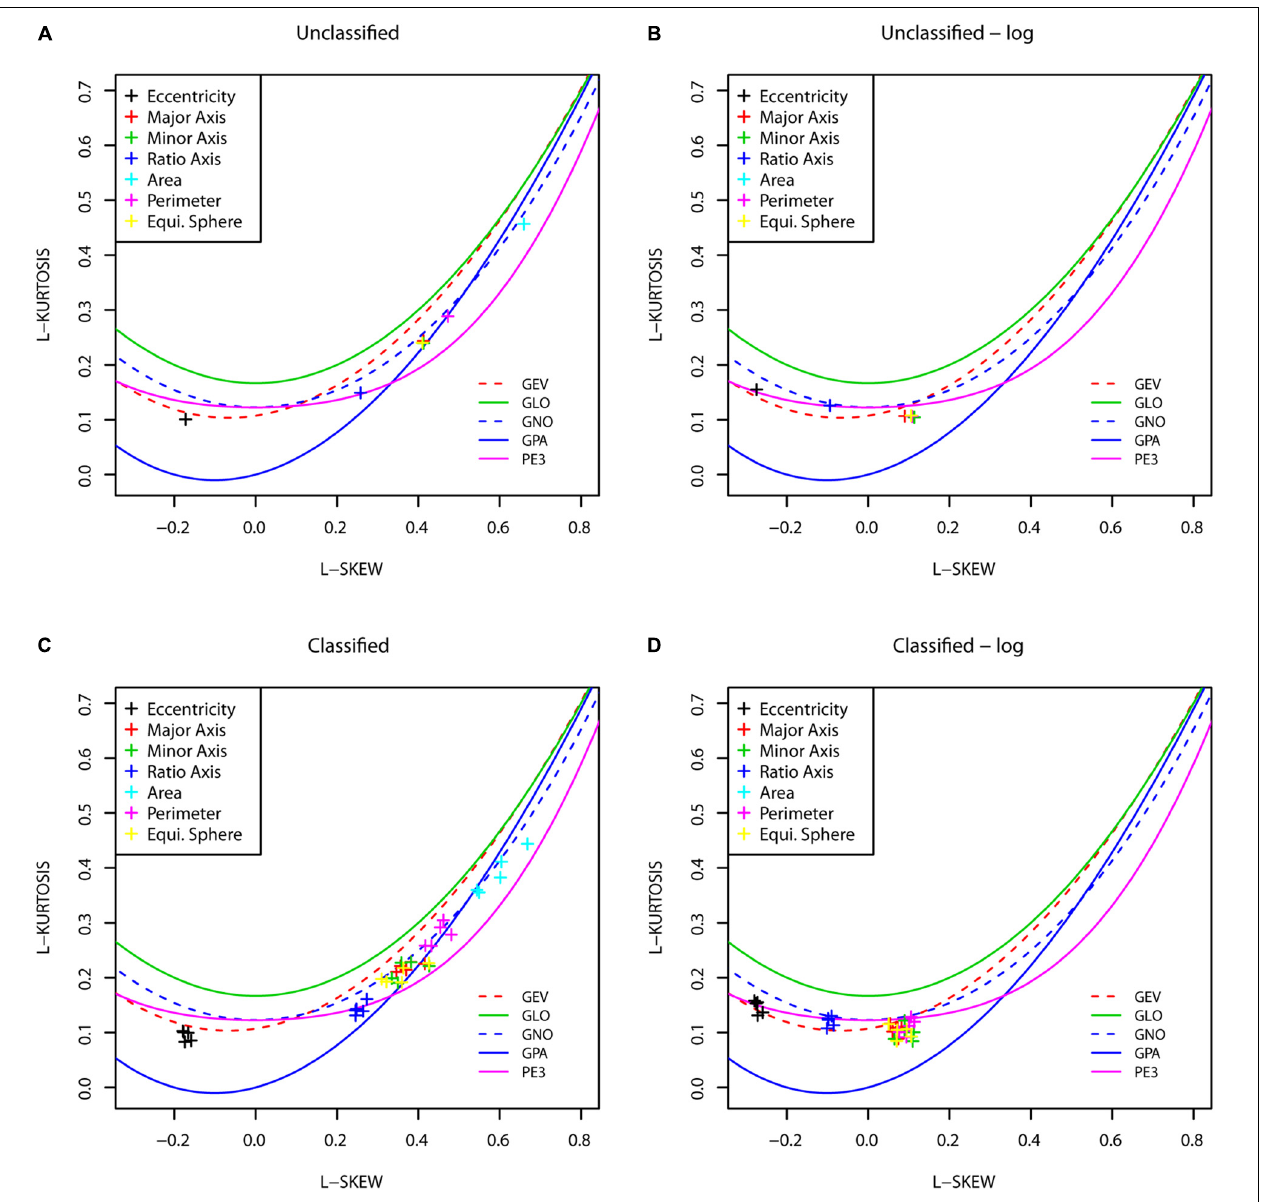
FIGURE 2 | L-moment ratio diagrams for the unclassified snow grain dataset (A,B) (only one point for each metric) and for classified snow grains (C,D) . Classified snow grains include one point for each category: Facets, Depth Hoar and Precipitation Particles. The lines represent theoretical relationship between the L-skewness and L-kurtosis of known family of